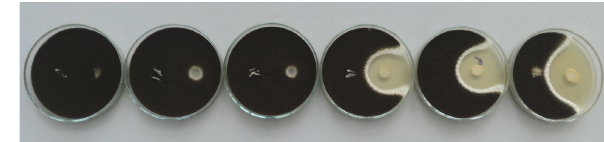
Figure 6: Inhibition zones of chitosan films with 0.5, 1, 2, 3, 4, and 5% wt. of the marjoram (left) and oregano (right) oils on Candida albicans .